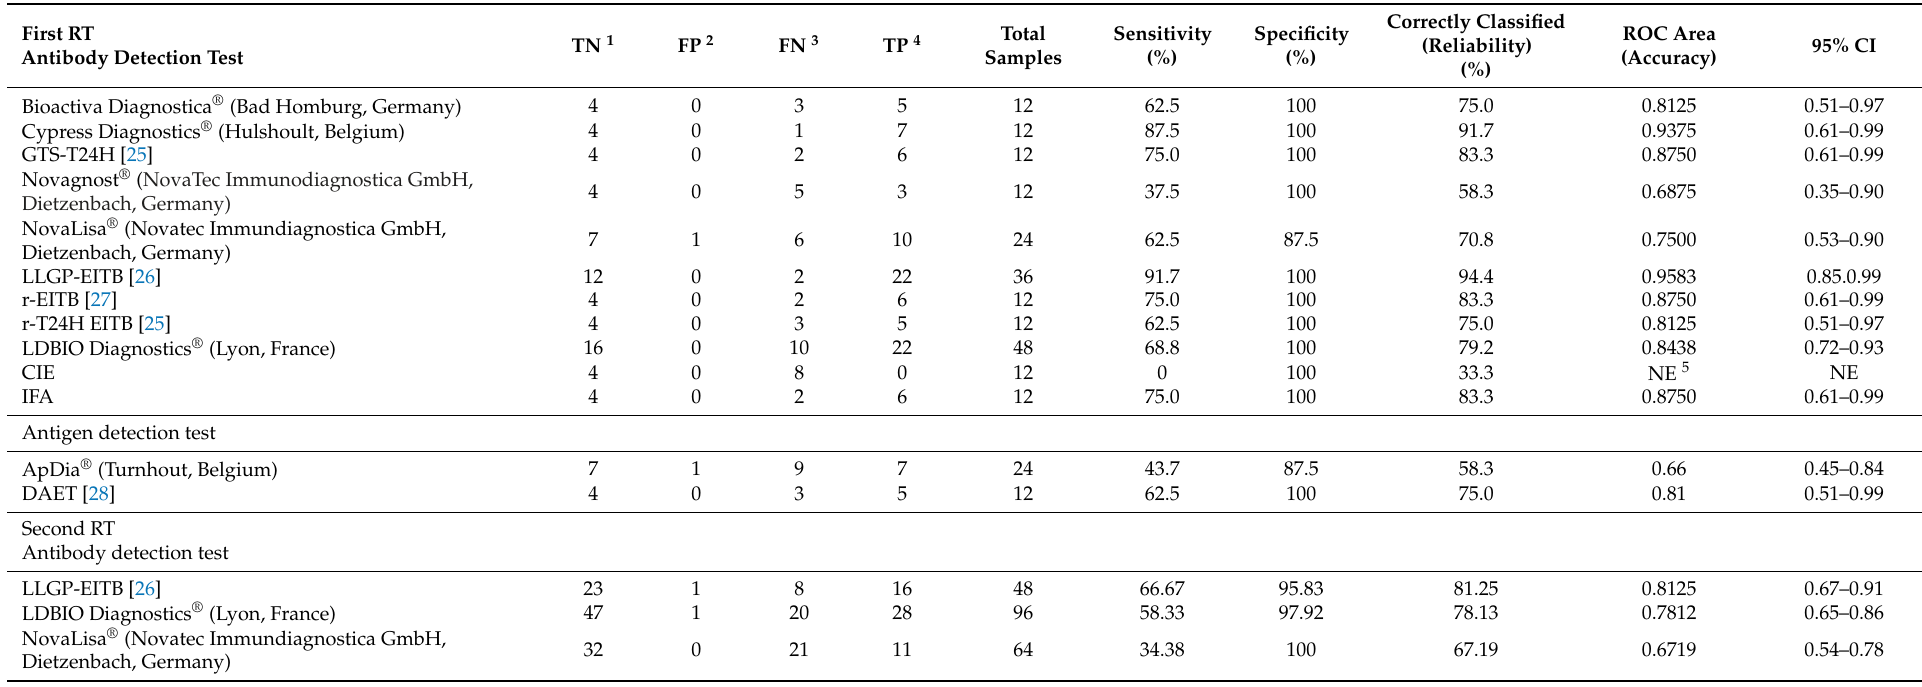
Table 5. Diagnostic accuracy by test of the first and second Ring Trials